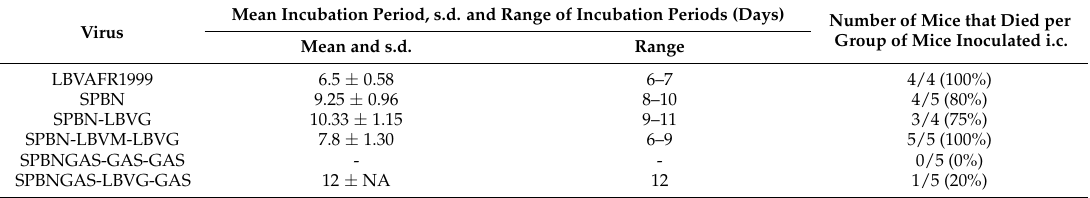
Figure 4. Pathogenicity of SPBN, SPBN-LBVG, SPBN-LBVM-LBVG, LBVAFR1999, SPBNGAS-GAS- GAS and SPBNGAS-LBVG-GAS in mice. Groups of 5 (Crl:CD1 [ICR]) mice were inoculated via the i.m. route with 5 × 10 6 TCID 50 /50 μ L of virus. The experiment was terminated after 43 days, but no clinical signs were observed 16 days post infection.